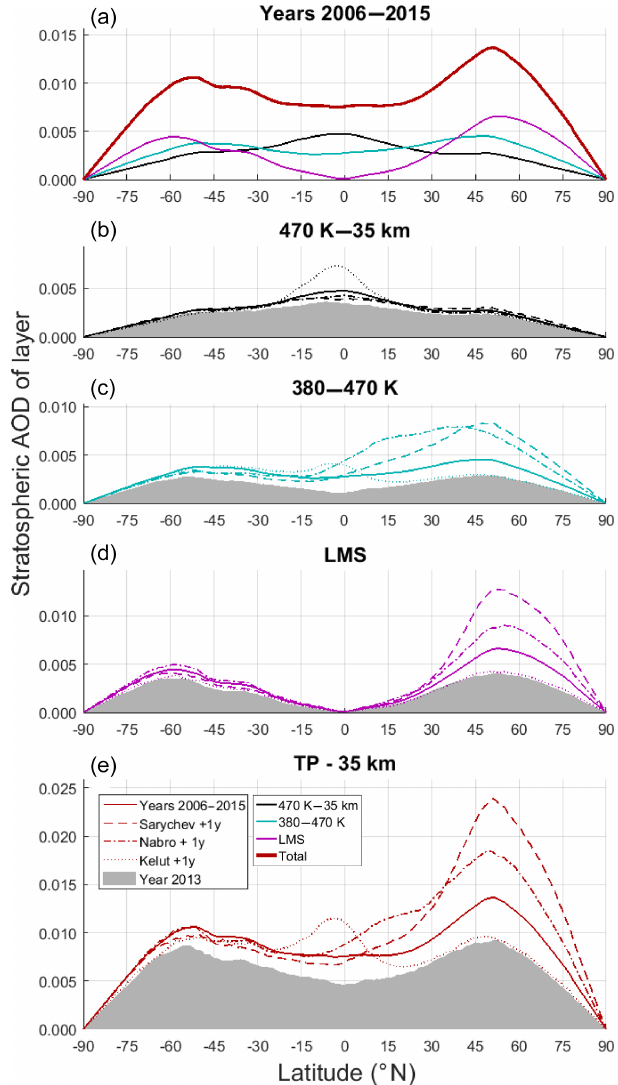
Figure 9. The latitudinal distribution of the latitude-weighted AOD. (a) The AOD of the different stratospheric layers and of the total stratospheric AOD (thick red) for the entire period (2006–2015). (b) – (d) The respective layers and (e) the AOD of the entire strato- spheric column, for the time periods noted in the legend. Lines rep- resent AODs in the altitude intervals 470K to 35km (black), 380– 470K (cyan), the LMS (magenta), and the entire stratosphere (thick red). The year 2013 (grey filling) is considered as background con- dition, and the line styles mark the different periods, as noted in the